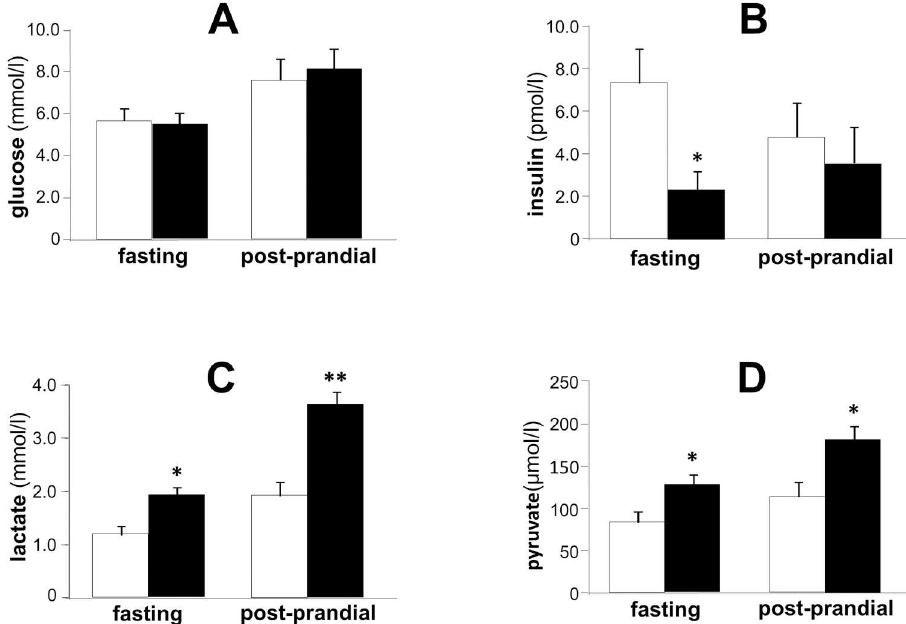
Fig 3. Effects of metformin on plasma concentrations of glucose (A), insulin (B), lactate (C) and pyruvate (D) in SD rats at 15 weeks old. Open bars denotecontrol group and black bars denote metformin- treated group. Data are presented as mean ± S.E. (n = 6 in each group). * P < 0.05, ** P < 0.01vs. control group.